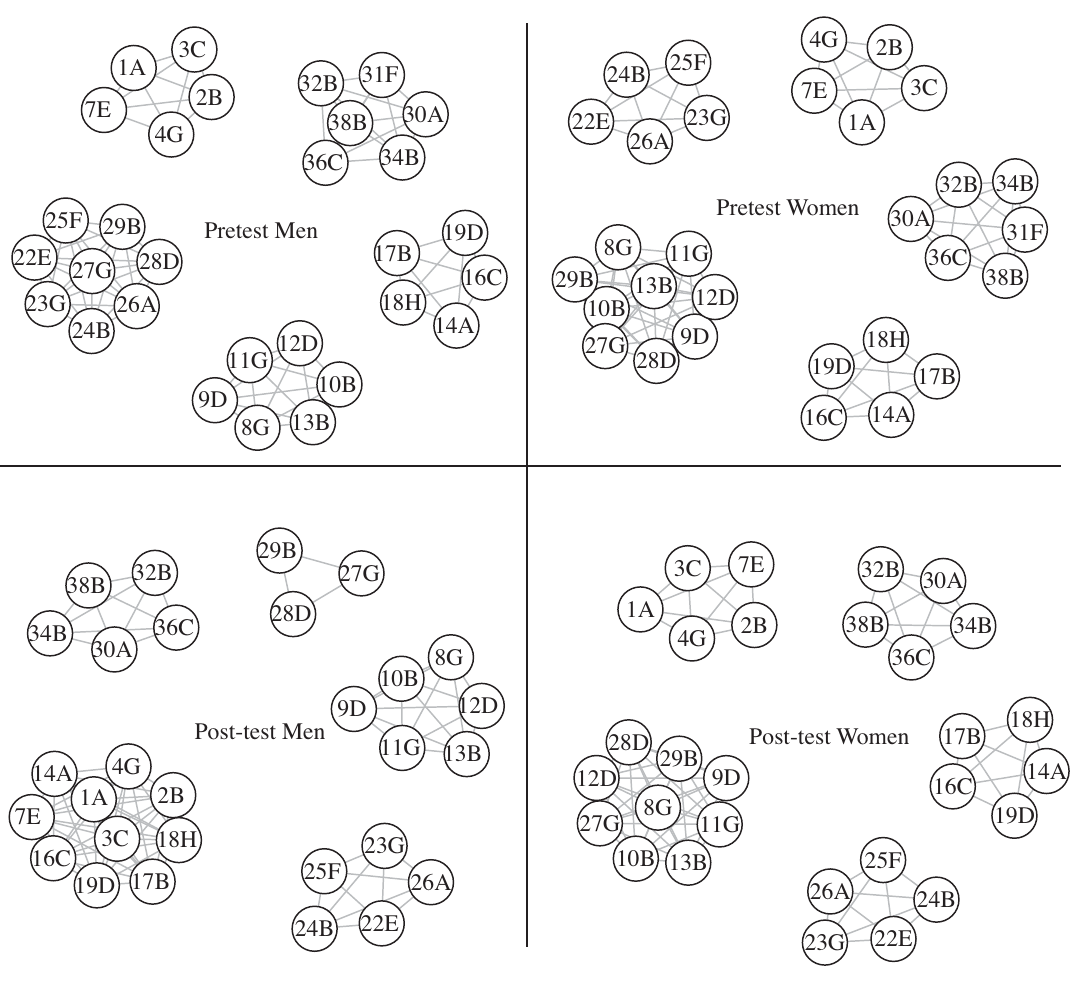
FIG. 1. Communities identified in the FMCE pretest and post-test for men and